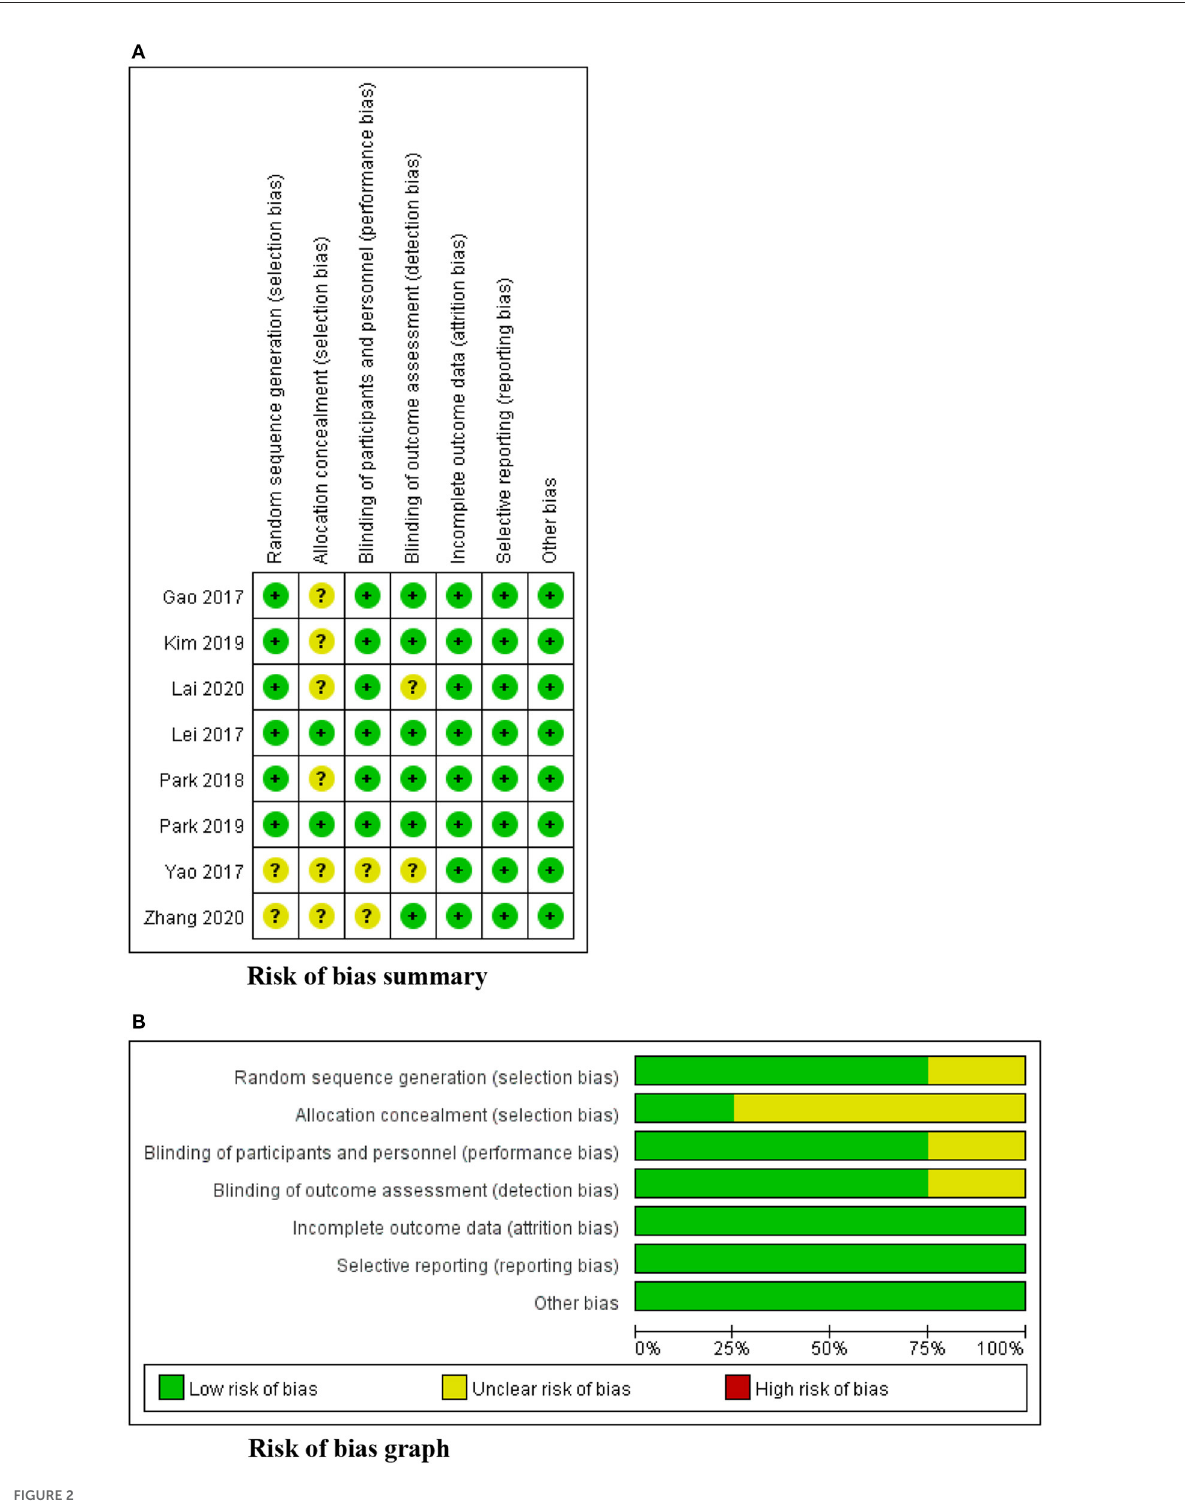
FIGURE2 Risk of bias (A) summary (B)